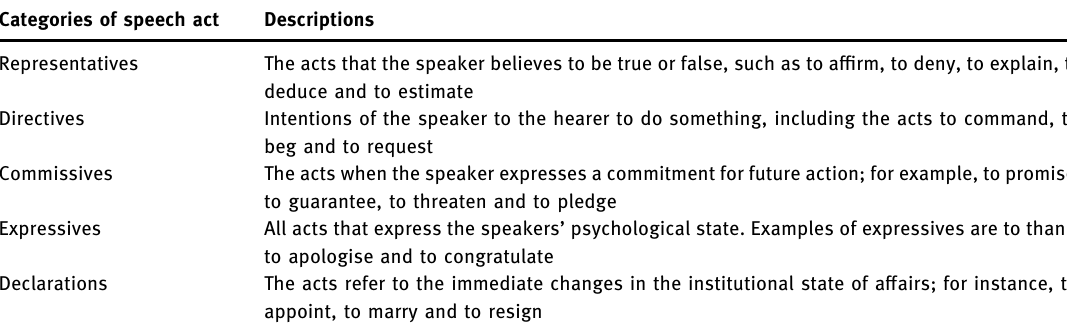
Table 1: Searle ’ s ( 1969 ) categories of illocutionary speech acts